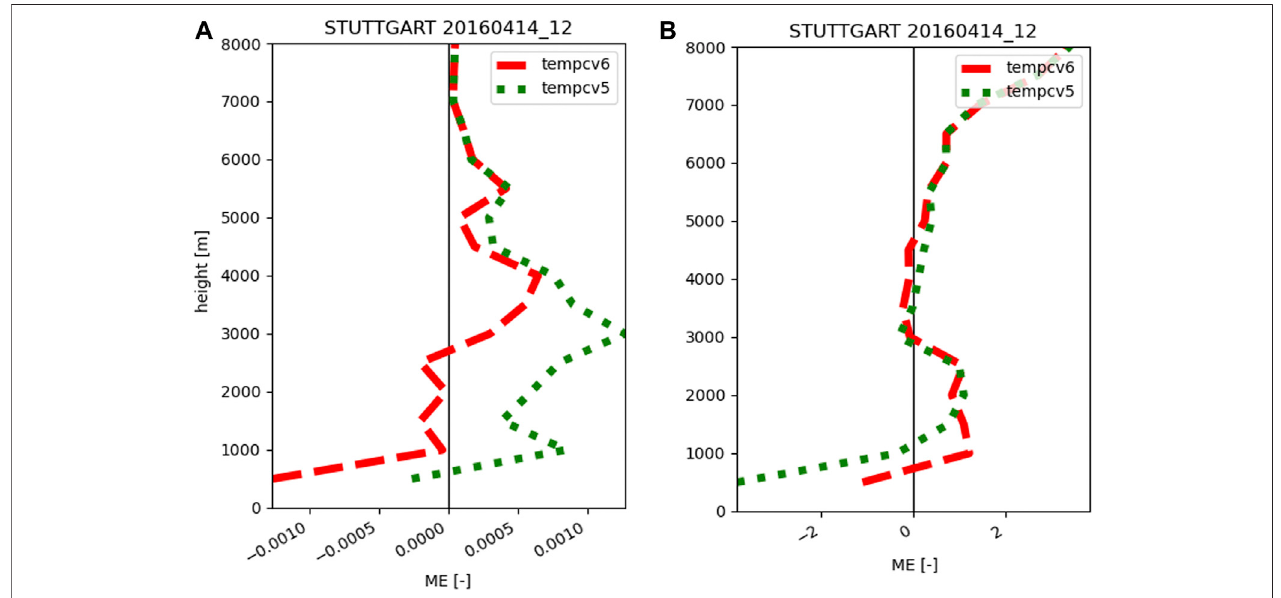
FIGURE 10 | Mean error of the mixing ratio (A) and temperature (B) for the 14th of April 2016 12 p.m. comparing the assimilation of temperature only with radiosonde data, based on the cv6 BE option (red) and the cv5 BE option (green) for Stuttgart.